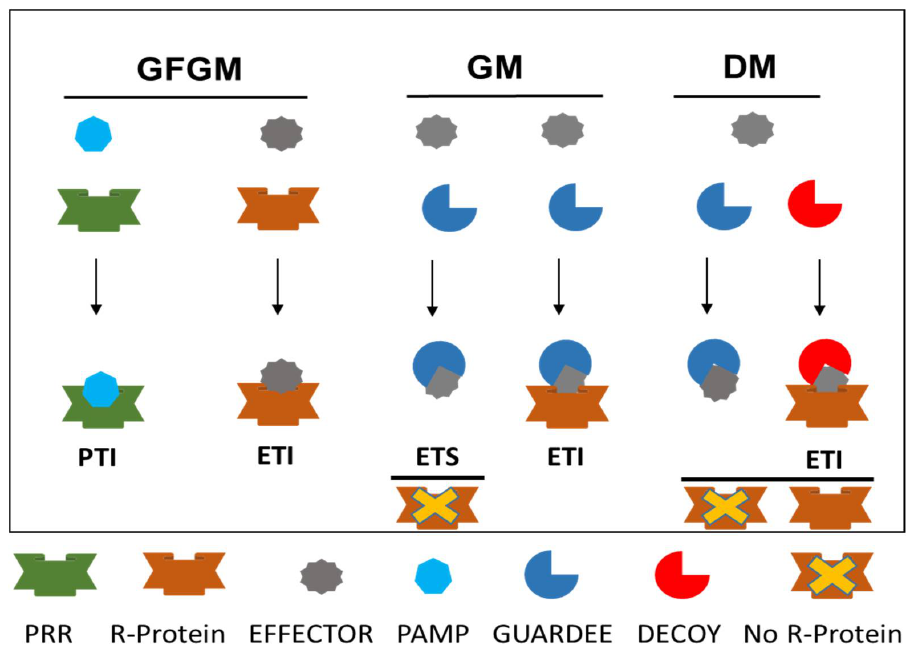
Figure 5. Simplified diagrammatic representation of models on host disease-resistance mechanism. Gene for gene model (GFGM): Physical interaction of pathogen-derived PAMP (pathogen associ- ated molecular pattern) with DR protein (pattern recognition receptor, PRR) ,resulting in PAMP- triggered immunity (PTI); physical interaction of Avr (effector) with R protein (NBS-LRR), resulting in effector-triggered immunity (ETI); Guard Model (GM): Interaction of effector with guardee trig- gers effector-triggered immunity (ETI) by their interaction with R protein (NBS-LRR). However, in the absence of R protein, binding of guardee with effector enhances the susceptibility/fitness of the pathogen (ETS); Decoy Model (DM): Interaction of effector with decoy triggers effector-triggered immunity (ETI) with the interaction of R protein (NBS-LRR), however, in the absence of R protein, there is no increase in the virulence/fitness of the pathogen.